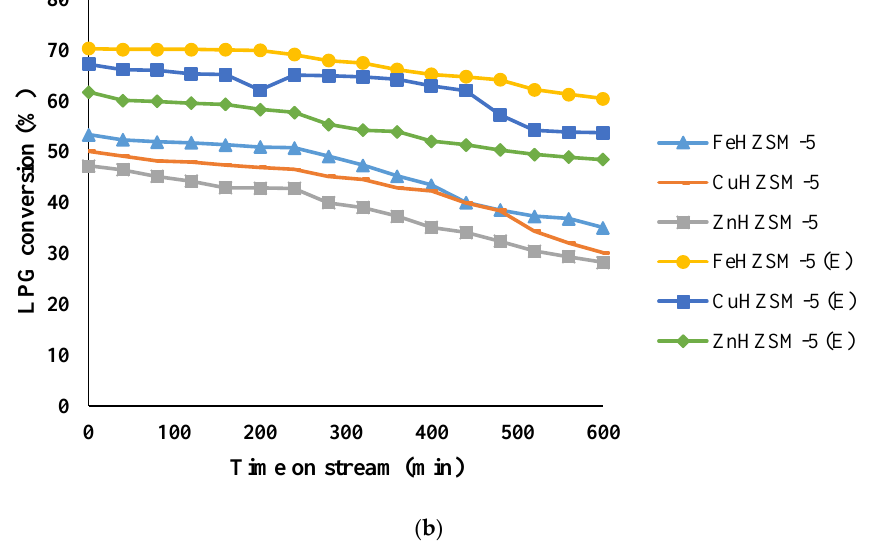
Figure 15. Effect of time on stream in oxidative dehydrogenation for 4 wt. % FeHZSM-5, 4 wt. % CuHZSM-5 and 4 wt. % ZnHZSM-5 catalysts in the presence and absence of electric field: ( a ) Olefin yield; ( b ) LPG conversion: 100 mg catalyst, 625 °C, 6 mA, 10 mm gap distance and 4 wt. % metal loading.